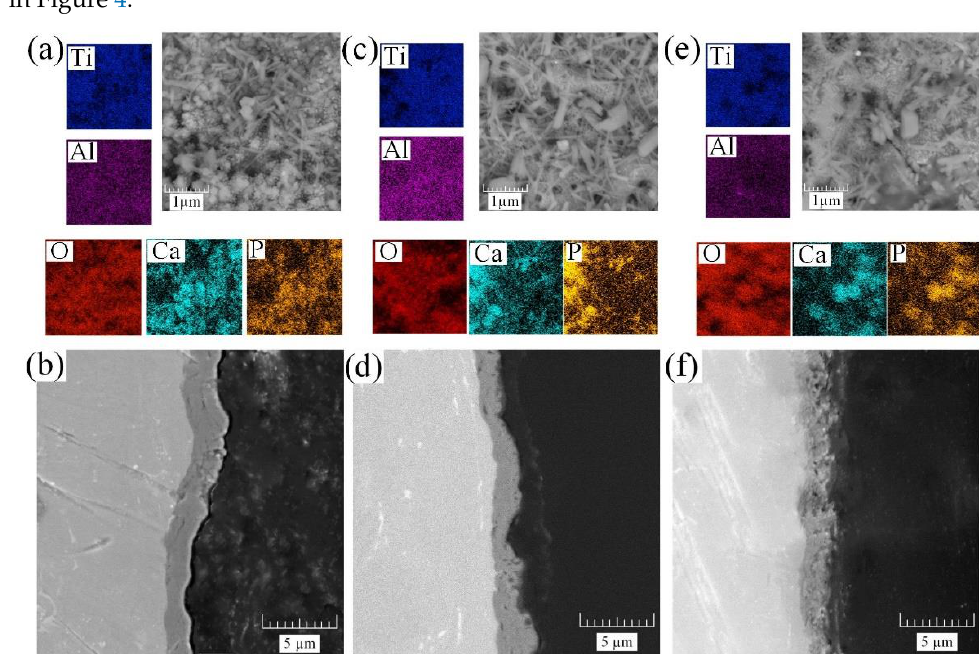
Figure 4. Morphology, EDS analysis, and cross-section of coated samples after the HTT process: ( a , b ) S1 HTT; ( c , d ) S2 HTT; ( e , f ) S3 HTT. Color scale for determining the chemical elements: